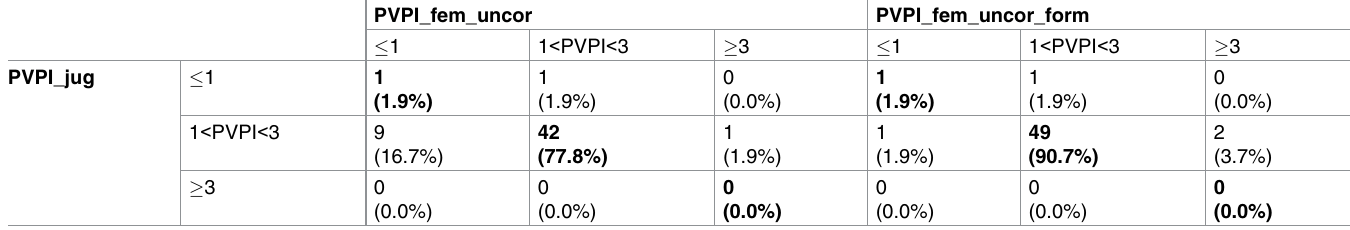
Table 3. Measurements of pulmonary permeability index PVPI_fem_uncor and PVPI_jug categorized “PVPI (cid:21) 3”, “1 < PVP < 3” and “PVPI (cid:20) 1”. Mea- surements classifiedin the same category are depictedin bold